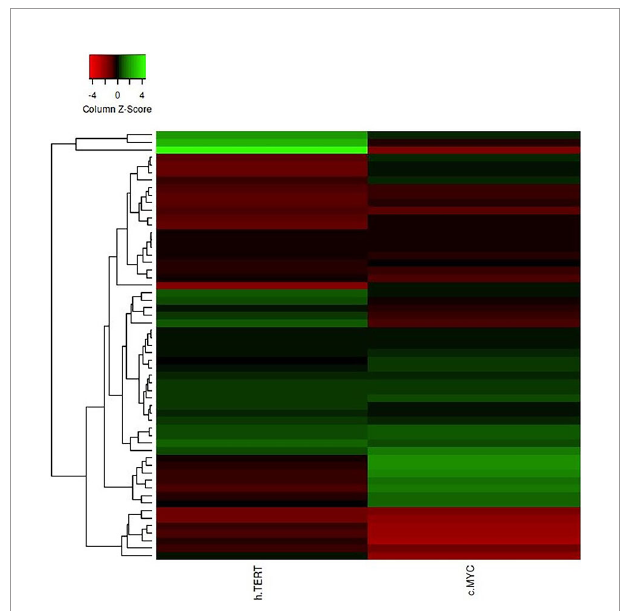
FIGURE 7 | Interaction of hTERT and c-Myc genes with other critical genes using various networks. Each color represents a different type of interaction and its role in various biological